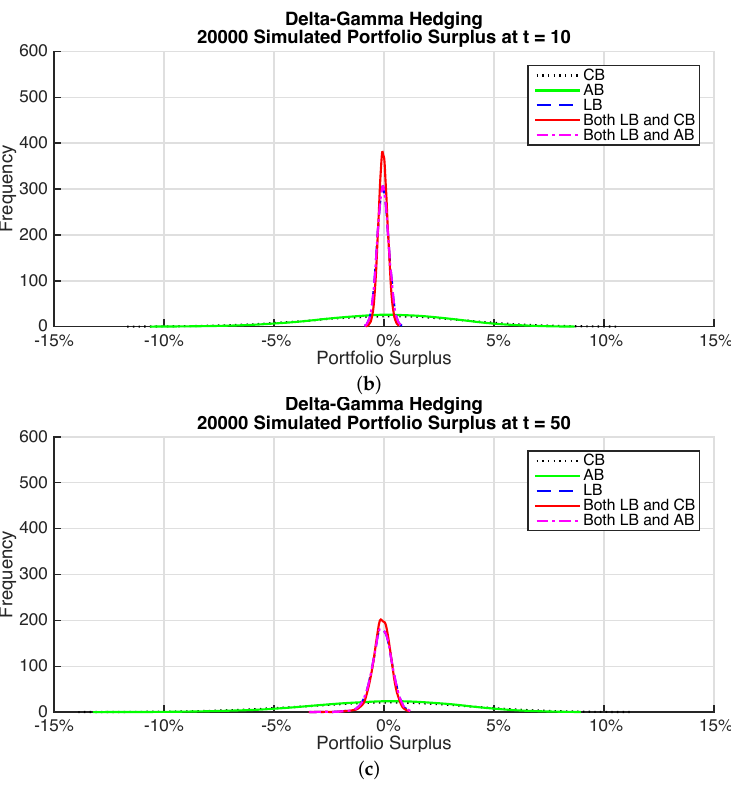
Figure 7. Surplus Distribution—Delta-Gamma hedging. ( a ) Time horizon—1 year; ( b ) Time horizon—10 years; ( c ) Time horizon—50 years.